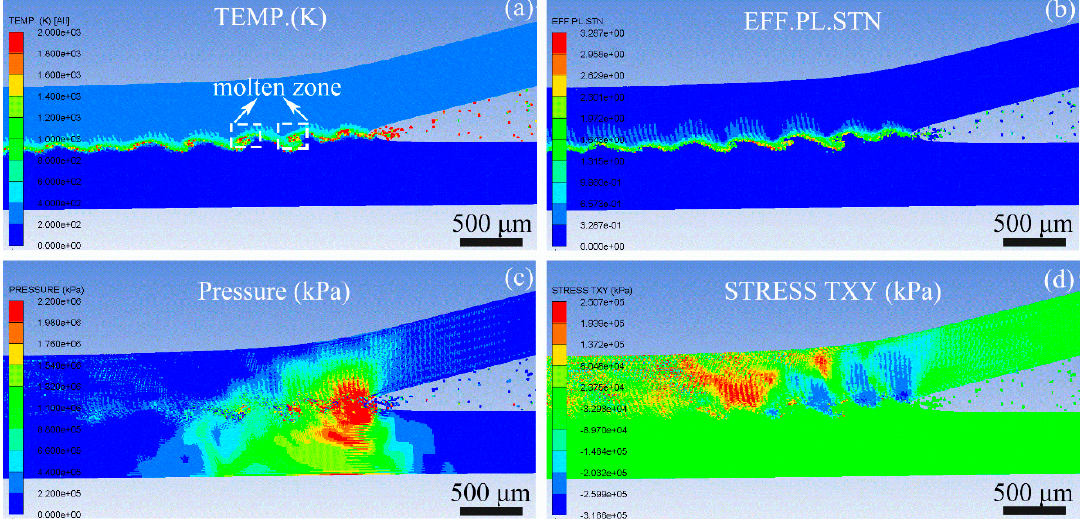
Figure 10. Interface between AA5052 and AZ31B, ( a ) temperature in Kelvin using SPH, ( b ) plastic strain using SPH, ( c ) pressure using SPH, ( d ) shear stress using SPH.